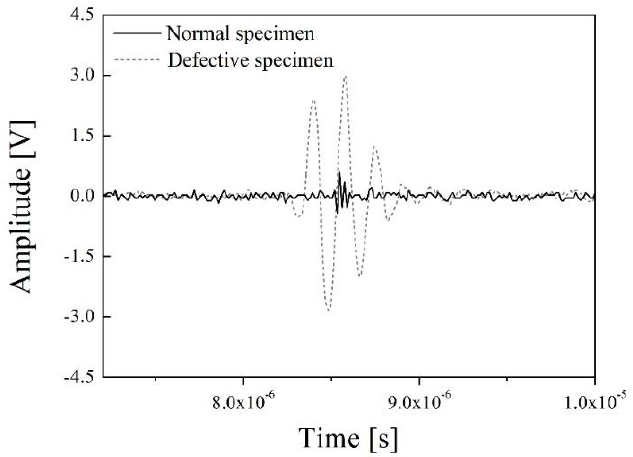
Figure 9. Through-transmitted response waveforms of the normal and defective specimens.